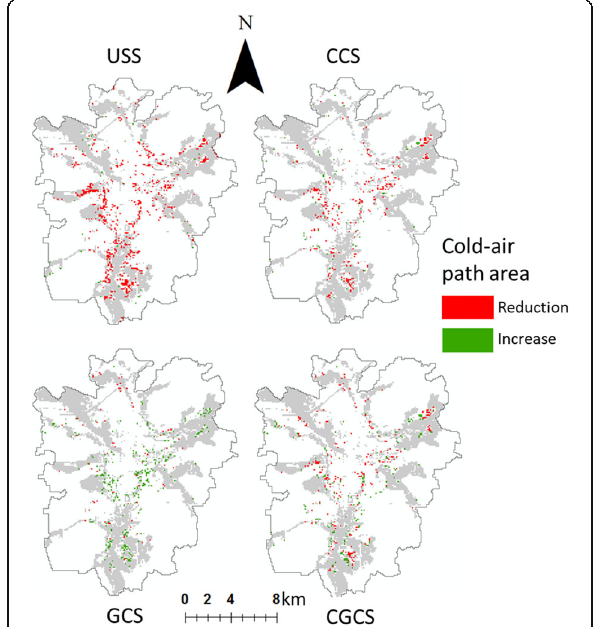
Fig. 6 Cold-air path area (areas with a cold-air path occurrence probability ≥ 60%) increase (green) and reduction (red) averaged over the 10 steps in comparison to the reference case (lightgrey areas) for the scenarios (USS: Urban Sprawl Scenario, CCS: Compact City Scenario, GCS: Green City Scenario, CGCS: Compact Green City Scenario)